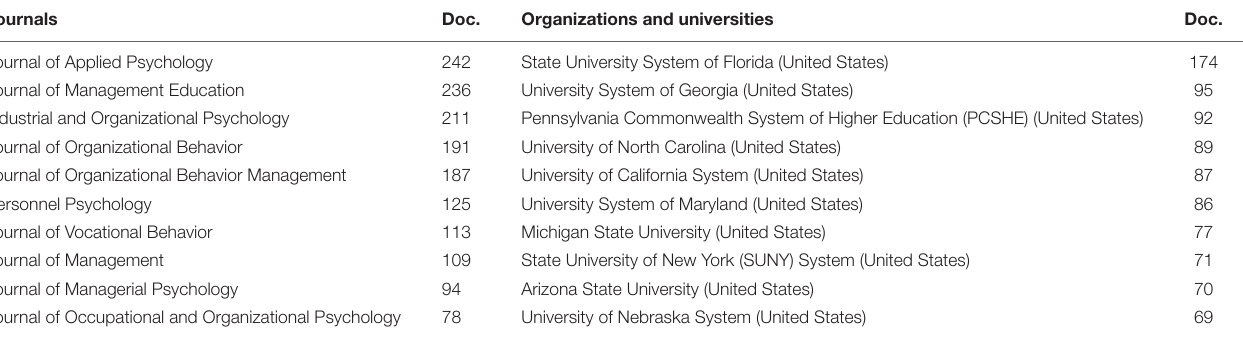
TABLE 1 | Journals and universities that most published studies related to WOP.